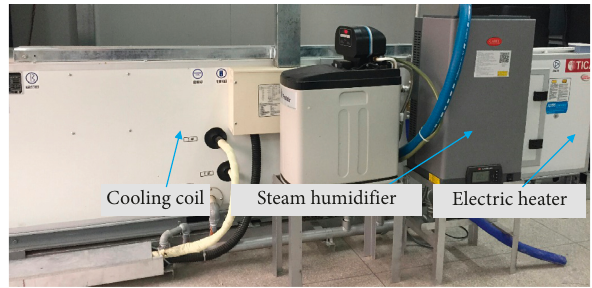
Figure 2: Photograph of the air-conditioning equipment.